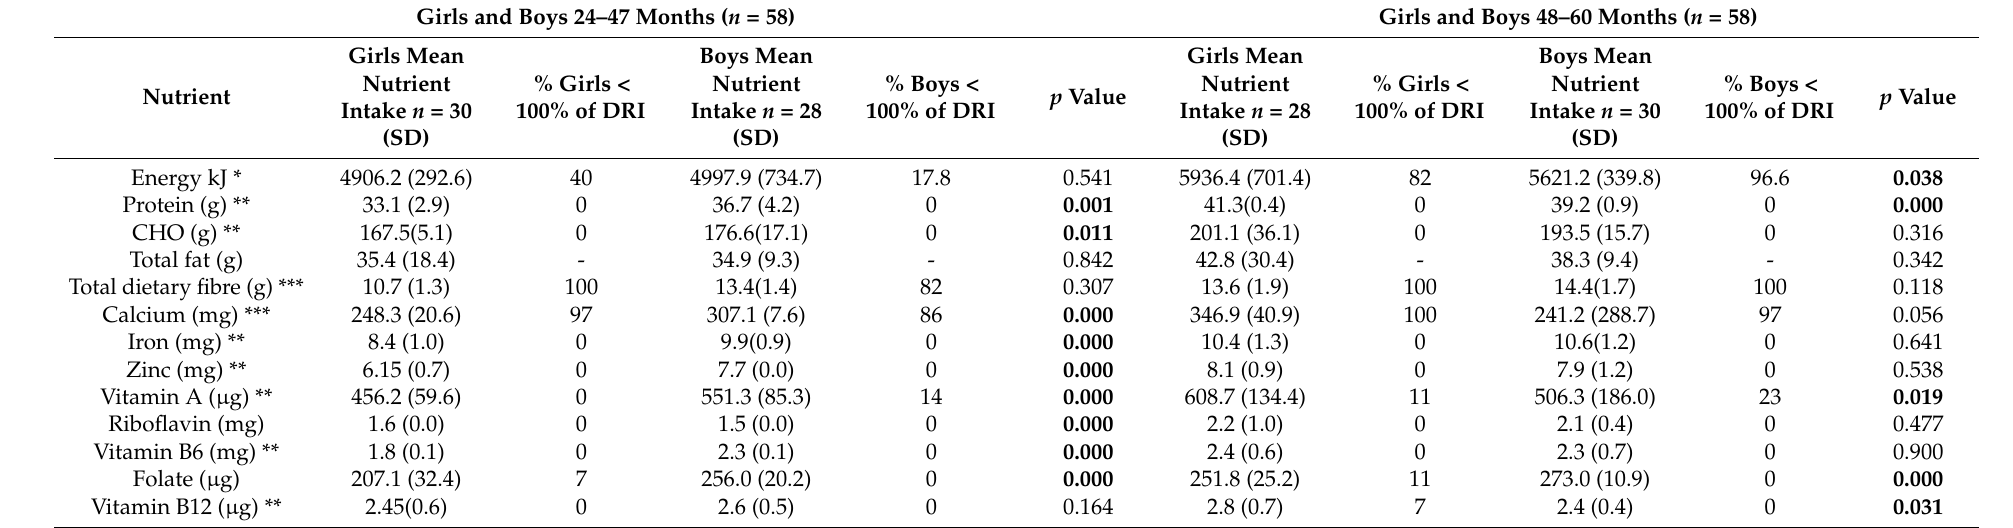
Table 1. Mean dietary intake for girls and boys ( n = 116) 24–60 months as measured by the 24 h food recall.